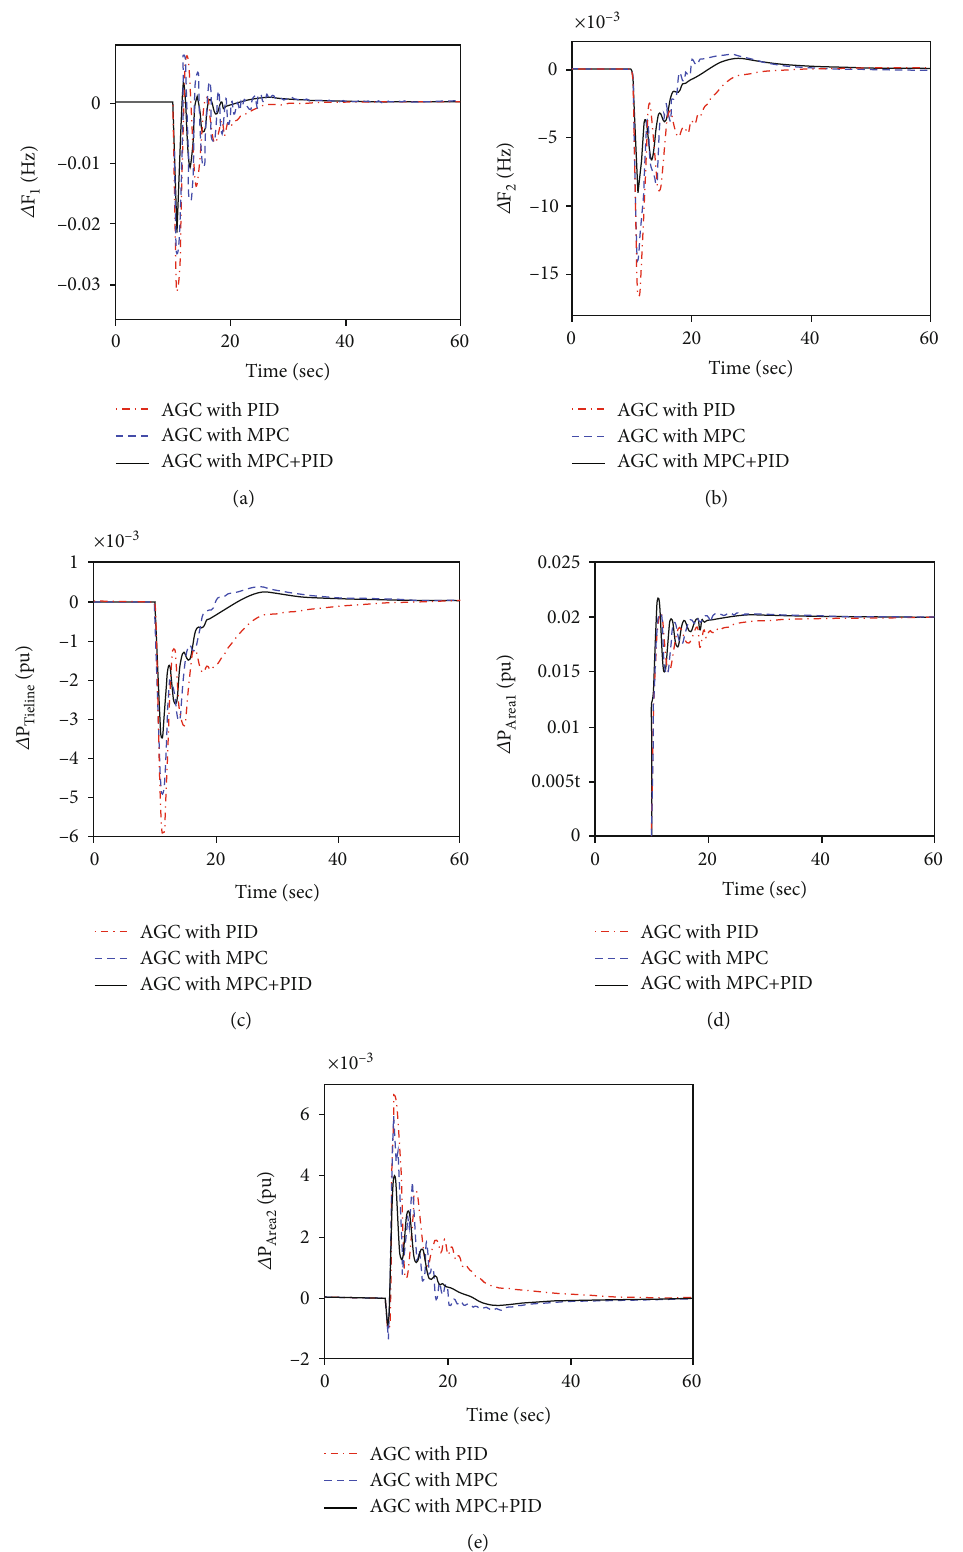
Figure 4: Dynamic performance of multisource power system model for 2% load disturbance in area-1 and 20% parameter variation. (a) Δ F Δ F Δ P Δ P 1 vs. time, (b) 2 vs. time, (c) tie vs. time, (d) area − 1 vs. time, and (e)